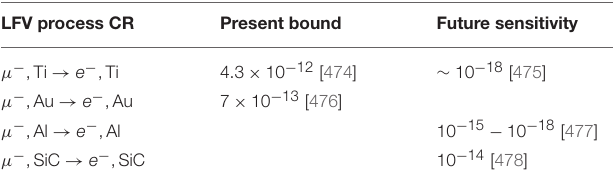
TABLE 3 | Current experimental bounds and future sensitivities for µ conversion in